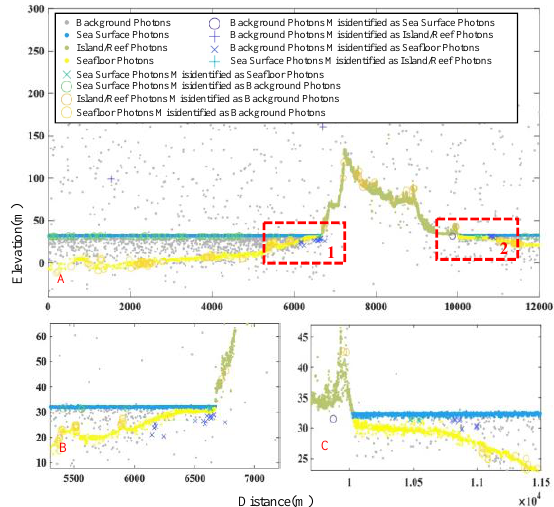
Figure 8 . Denoising and classification results for Dataset.